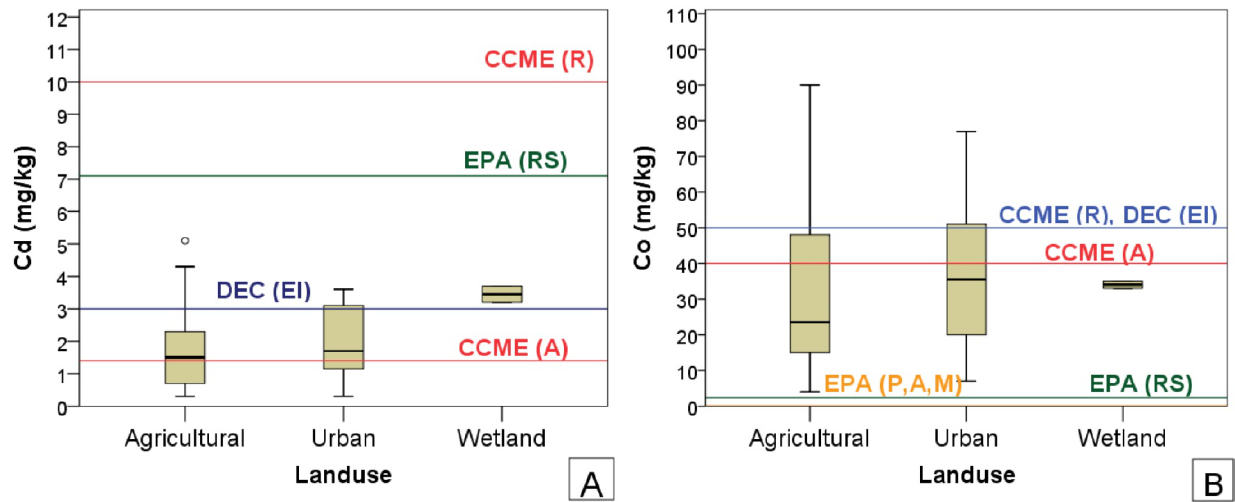
Figure 7. Boxplots for ( A ) Cd and ( B ) Co, comparing element concentration to guideline established by the literature (EPA, CCME and DEC). EPA (RS): Residential soil regional screening level, EPA (P,A,M): plant-avian-mammalian screening level, EPA (A,M): avian-mammalian screening level, CCME (A): soil quality guideline for agricultural land use, CCME (R): soil quality guideline for residential land use; DEC (EI): ecological investigation level.